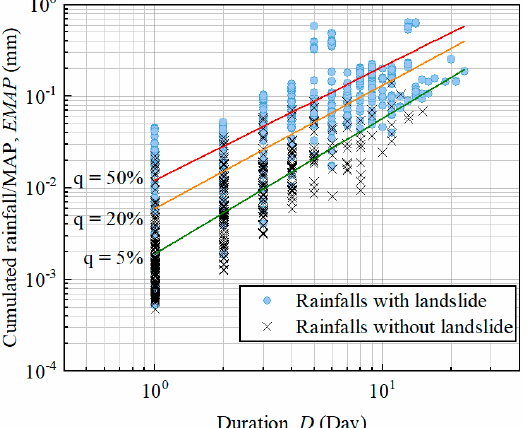
Figure 6. Double-log plot of landslide normalized cumulative rainfall EMAP versus time D for conditions triggering landslides and corresponding 5%, 20%, and 50% EMAP–D thresholds in Guangzhou.